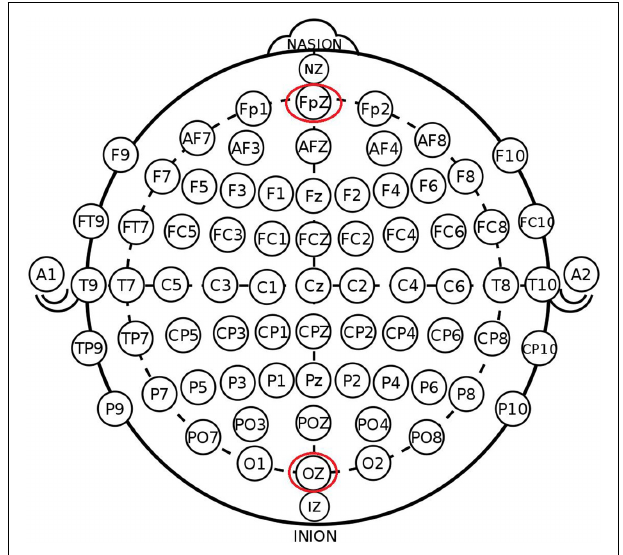
FIGURE 1 | Schematic and locations of electrode